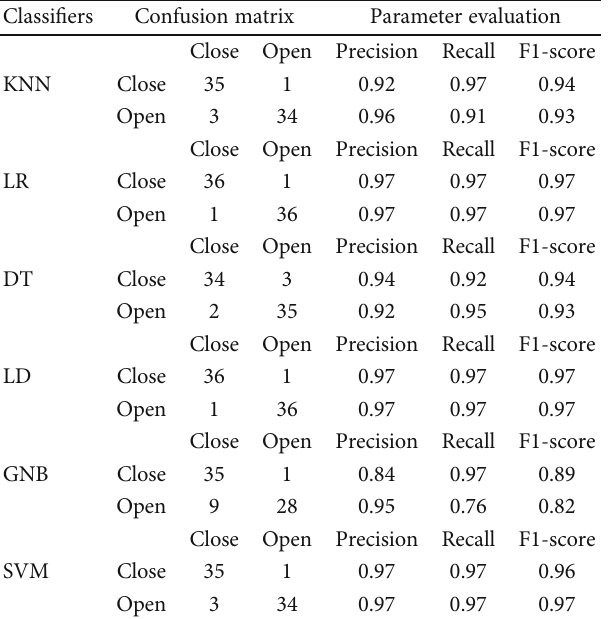
Table 4: Classi fi cation accuracies of classi fi ers applied to extracted features by SE.